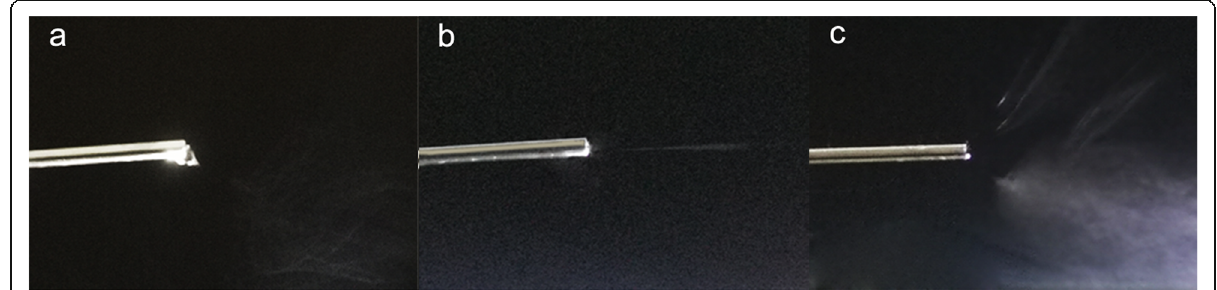
Fig. 8 The optical images of jet number in spinning process under voltage value a 15 kV, b 20 kV, and c 30 kV (the inner diameter of spinneret is 0.8 mm, outer diameter of spinneret is 1.2 mm)